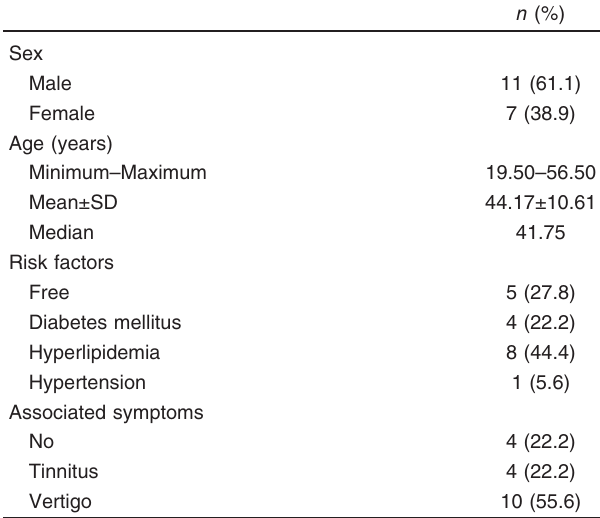
Table 1 Distribution of total cases according to sex, age, risk factors, and associated symptoms ( N =